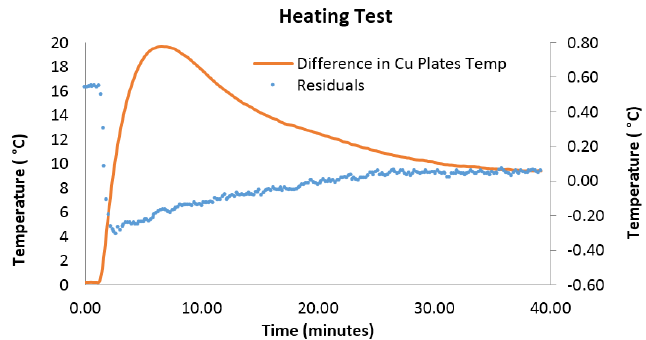
Figure 4. Heating temperature profiles of Cu plates and TSF.